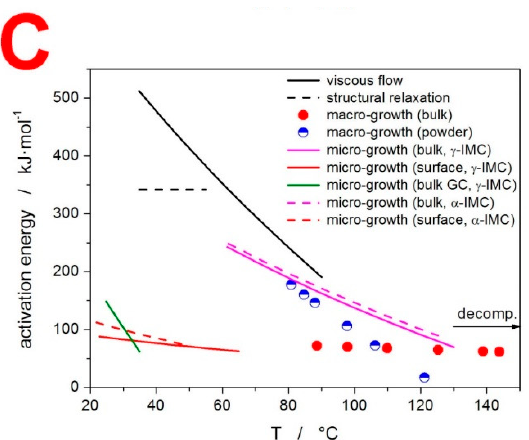
Figure 6. ( A ) Microscopic crystal growth rate data [13,54] fit by polynomial functions. Black-based points correspond to the γ form, and red-based points correspond to the α form. ( B ) Selected macroscopic crystallization data (in the form of the Kissinger plot, as depicted in Figure 5A, left axis) and viscosity data [55] (right axis) fit by polynomial functions. ( C ) Comparison of the temperature dependences of the activation energies in different processes occurring in the amorphous IMC. The magnitude of the decomposition activation energy is indicated by the horizontal arrow. The actual temperature range for this process is 170–330 ◦